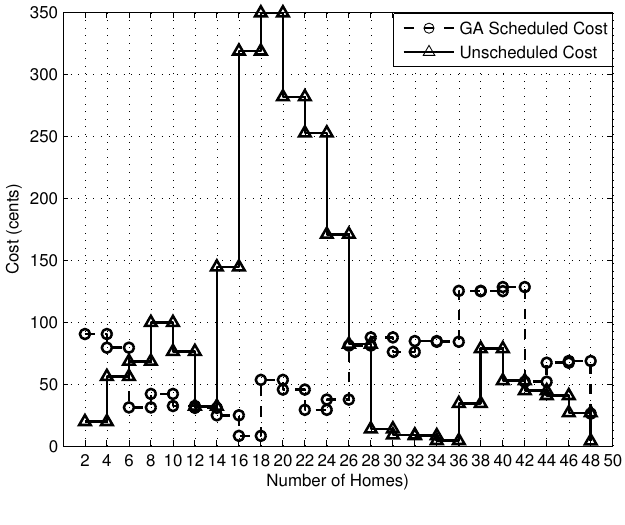
Figure 13. GA total